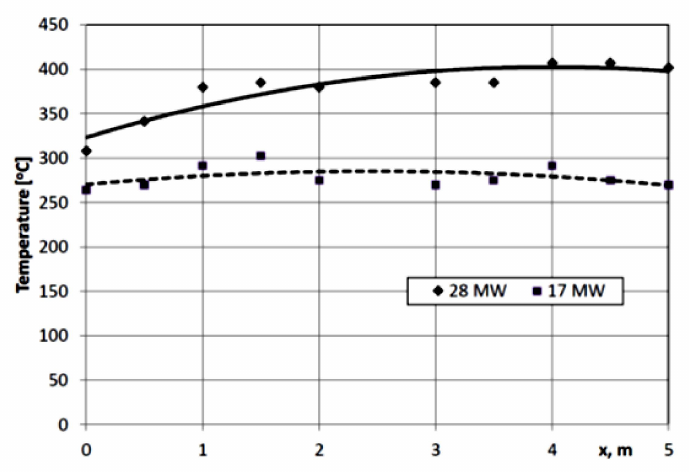
Figure 5. Temperature measurement in the space between the tube bank of the 2nd pass water heater for two boiler loads of 17 MW and 28